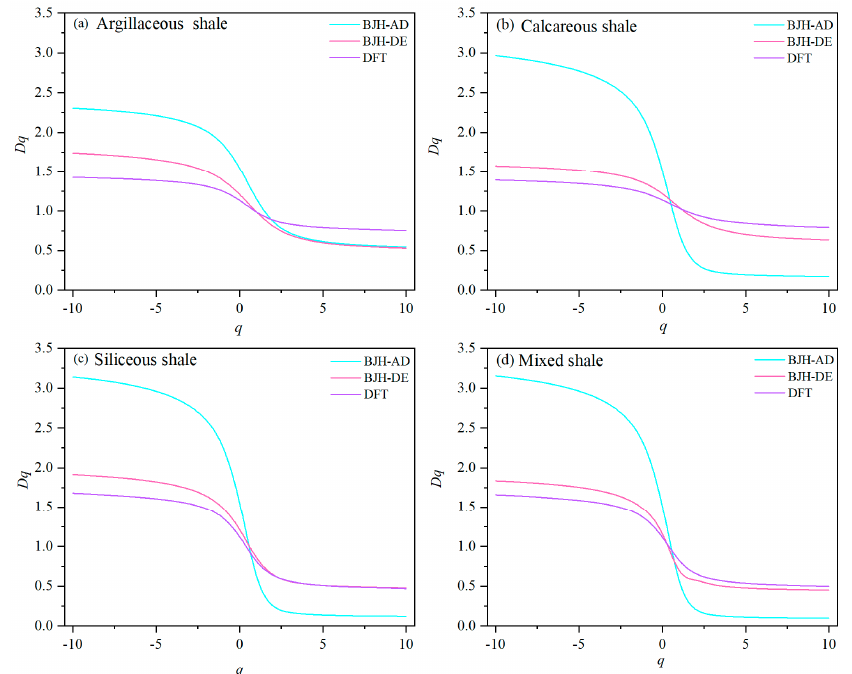
Figure 9. Generalized fractal spectra of different BJH and DFT models obtained from the N 2 adsorp- tion experiments: ( a ) Dq of argillaceous shale lithofacies; ( b ) Dq of calcareous shale lithofacies; ( c ) Dq of siliceous shale lithofacies; ( d ) Dq of mixed shale lithofacies.